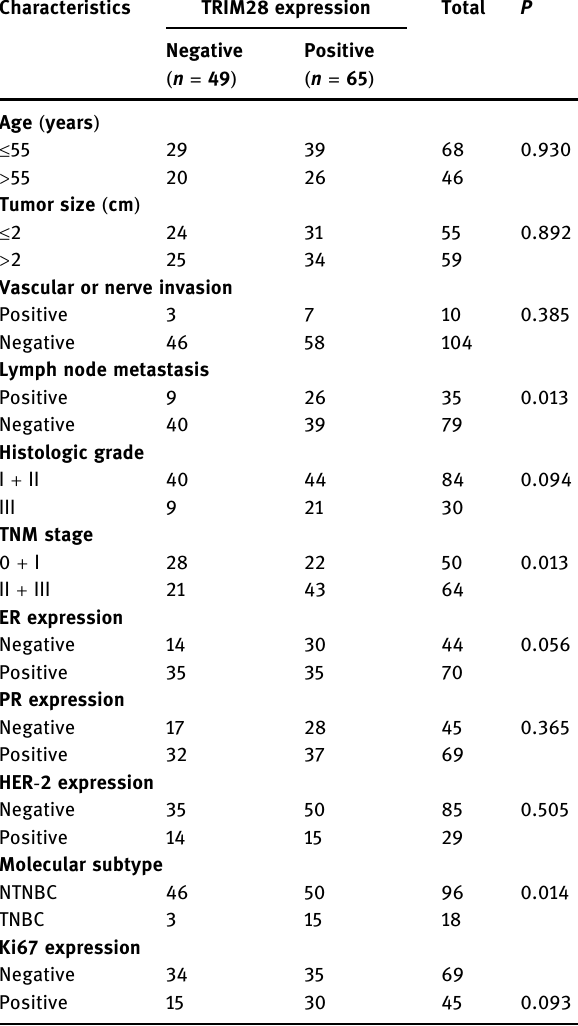
Table 1: Correlations of TRIM28 expression in breast cancer tissues with clinicopathological parameters